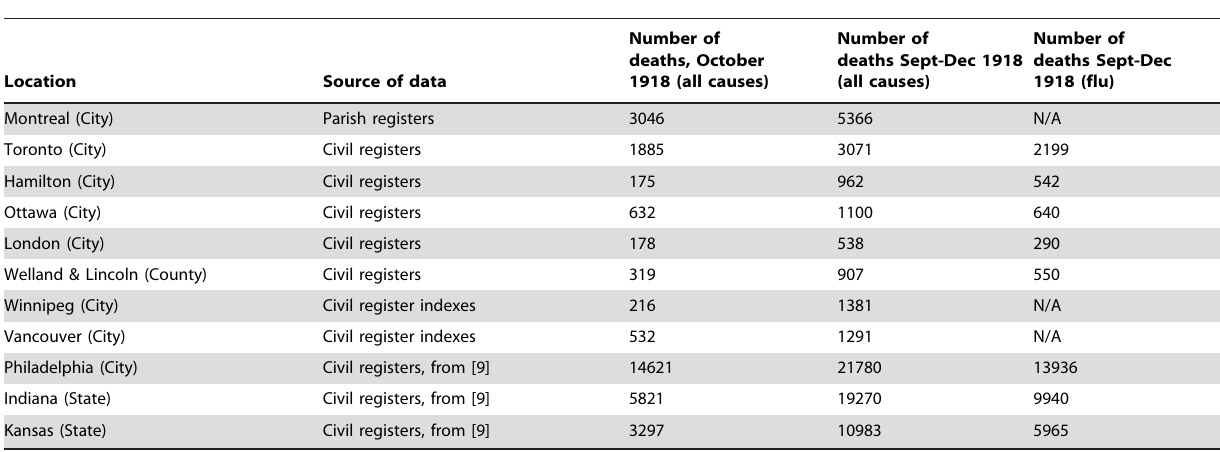
Table 1. Source and number of deaths (from all causes) recorded by selected locations during the 1918 flu pandemic.